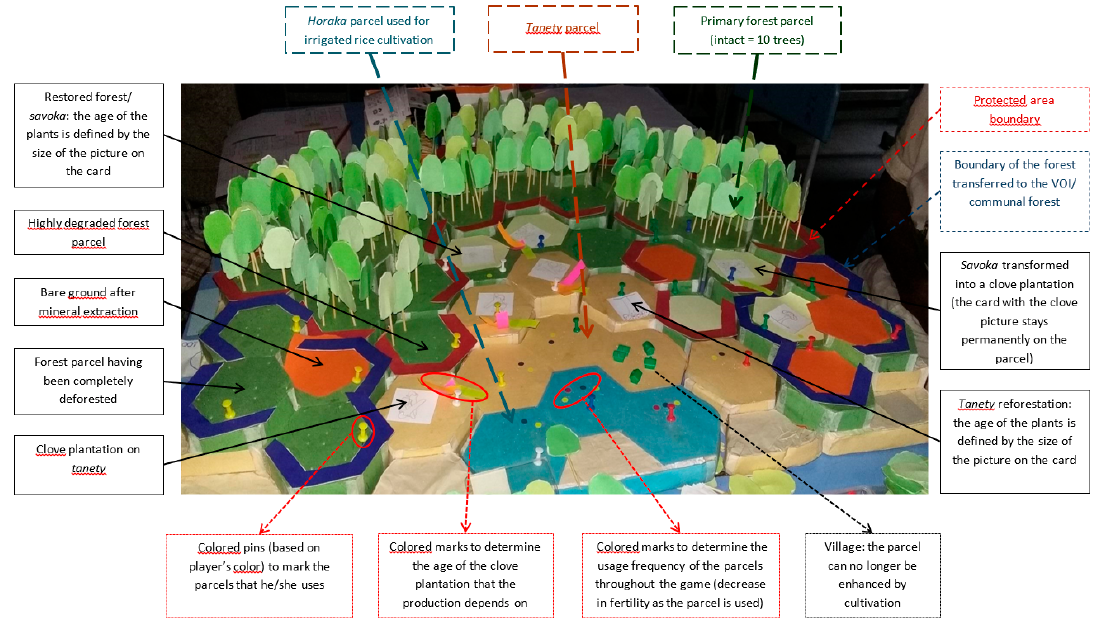
Figure A2. Original game board with tokens, pins, and the symbols indicating agricultural activities.